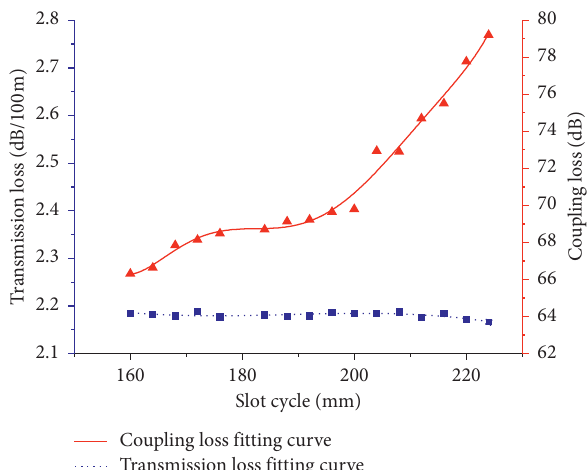
Figure 9: Relation between the cycle of U-groove and the loss of leakage cable.